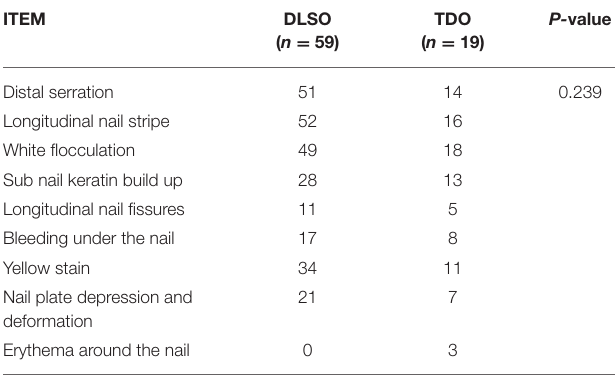
TABLE 6 | Distribution of dermoscopic dermatoscopic patterns between two subtypes of DLSO and TDO in 78 cases of onychomycosis. ITEM DLSO ( n = 59) Distal